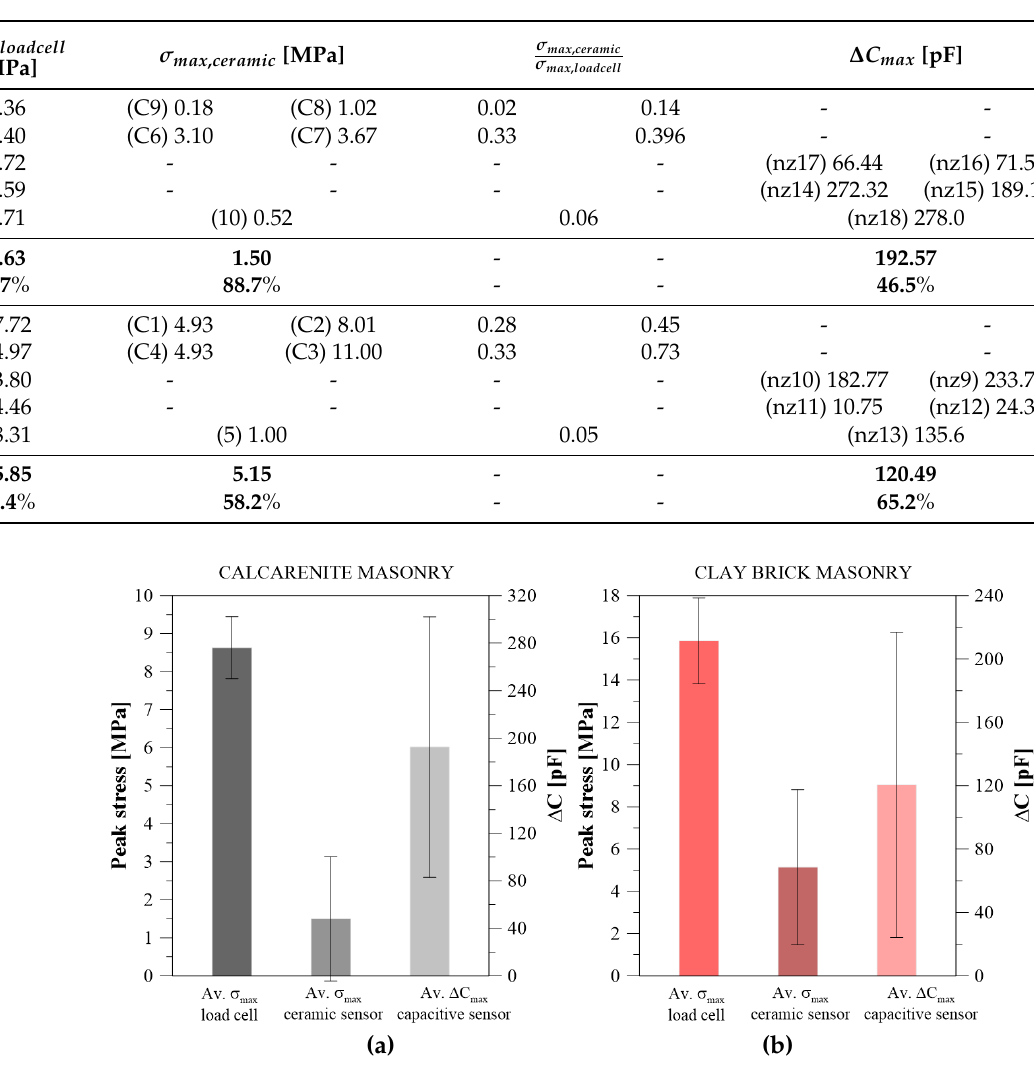
Figure 15. Average and standard deviation values according to post-installation system P1: ( a ) calcarenite masonry; ( b ) clay bricks